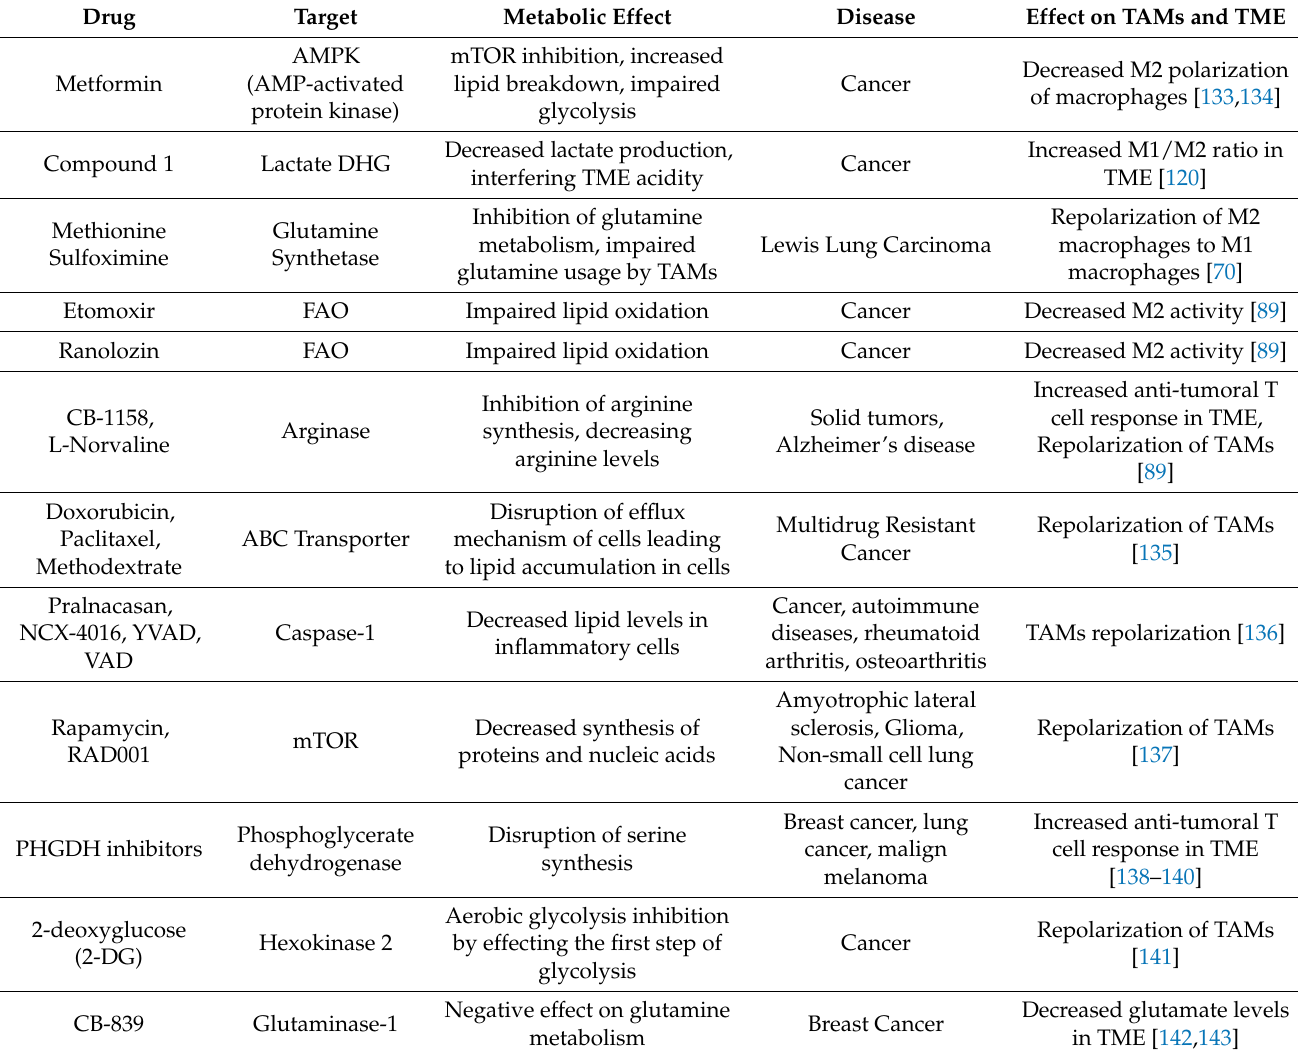
Table 1. Selected agents targeting TAM metabolism for the treatment of